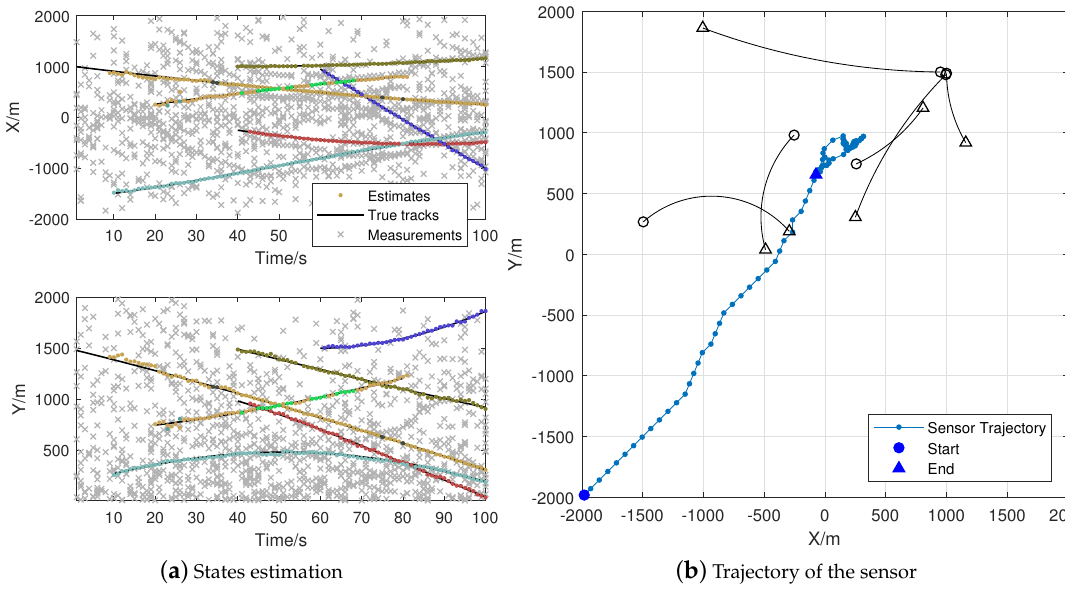
Figure 6. Dual sensor control algorithm with PAPD and